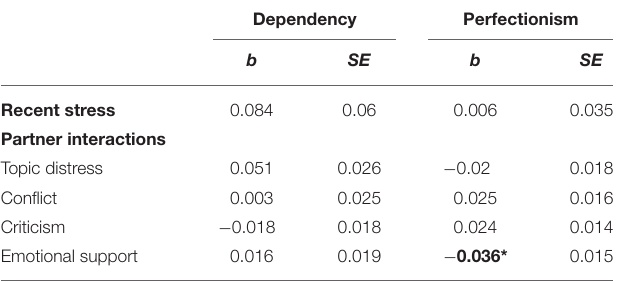
TABLE 2 | Fixed effects of dependency and perfectionism on recent stress and 4 different partner interaction